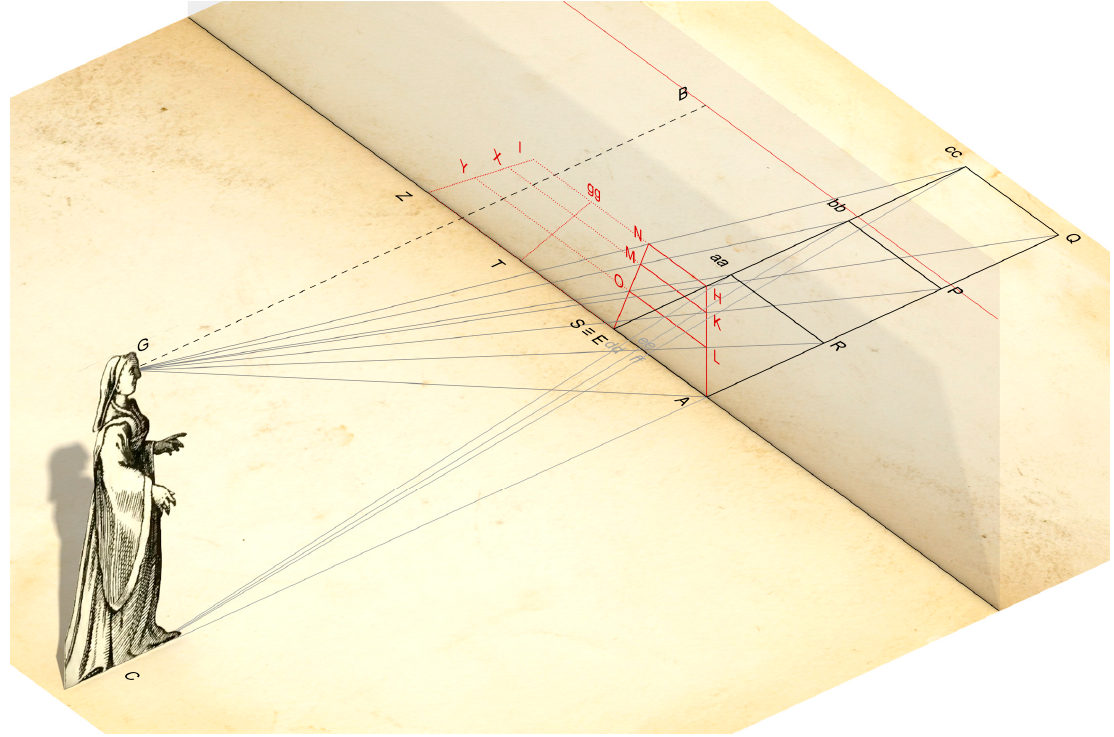
Figure 5. The digital model that illustrates the principles of the prospective representation outlined in the first rule.